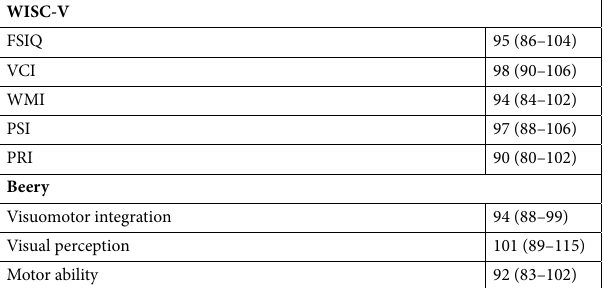
Table 3. Medians and interquartile ranges for the cognitive and visuomotor outcomes. WISC-V Wechsler Intelligence Scale for Children, fifth edition, FSIQ full scale intelligence quotient, VCI verbal comprehension